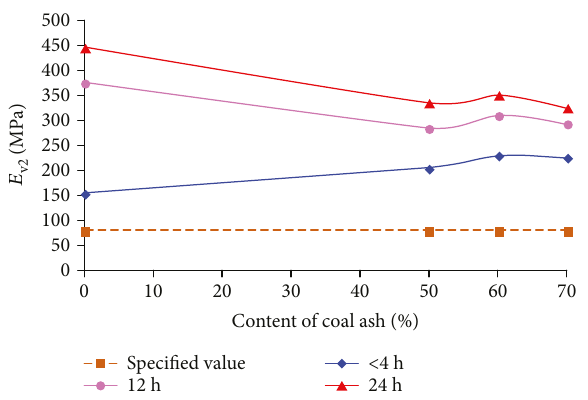
Figure 3: Relation diagram between the coe ffi cients of subgrade reaction K 30 and the content of coal ash.